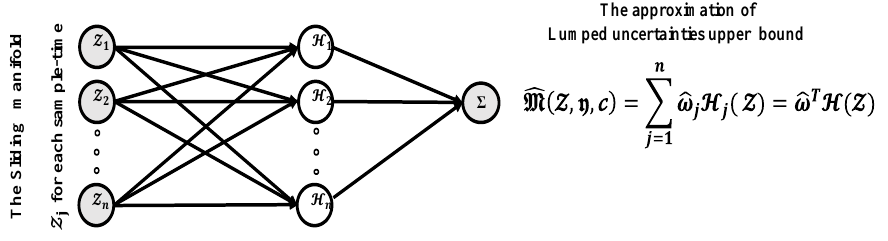
Figure 4. The RBNN Figure 4. The RBNN structure .